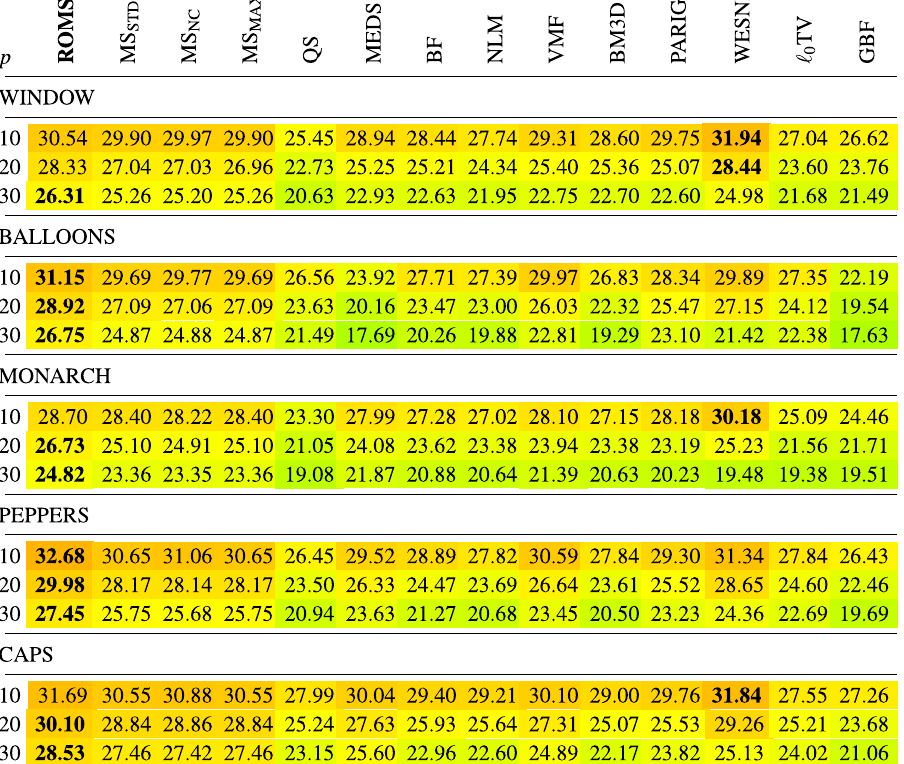
implementation. In addition, the Quick Shift and Medoid Shift were not able to effectively suppress the mixed noise, although the latter proved to be generally more effective when analyzing the PSNR results. Similar con- clusions can be drawn while analyzing the results in terms of the IRI (Table 2), SSIM and MSSIM measures (Tables 3, 4). Analyzing the obtained results presented in the Tables, the proposed denoising scheme outperforms other filters taken for comparison when the test images were distorted by mixed noise of high intensity. For lower con- tamination levels, only the WESNR filter achieved for some images slightly better performance. The IRI results show that the ROMS filter efficiently removes the impulsive noise outperforming other methods. The satisfying properties of the ROMS are also confirmed when scrutinizing the results in terms of SSIM and MSSIM. The very satisfying performance of the ROMS filters expressed using the objective quality measures can be also confirmed visually. Figures 7 and 8 show that the ROMS filter can cope, both with the pure impulsive and mixed noise, and it exhibits significantly better denoising efficiency than the competitive methods. The impulsive noise is much better attenuated, and the Gaussian component is efficiently reduced. The image details are well preserved, and the edges are even sharper than in the undistorted test images. The restoration results obtained using the WESNR show that the filter is prone to generate color artifacts, especially for high contamination levels. The enhancement results achieved using the PARIGI filter reveal that this filter tend to retain impulsive pixels and is not able to suppress the Gaussian noise for high contamination levels. It can be also observed that the standard Mean Shift is forced to increase the smoothing parameter to suppress